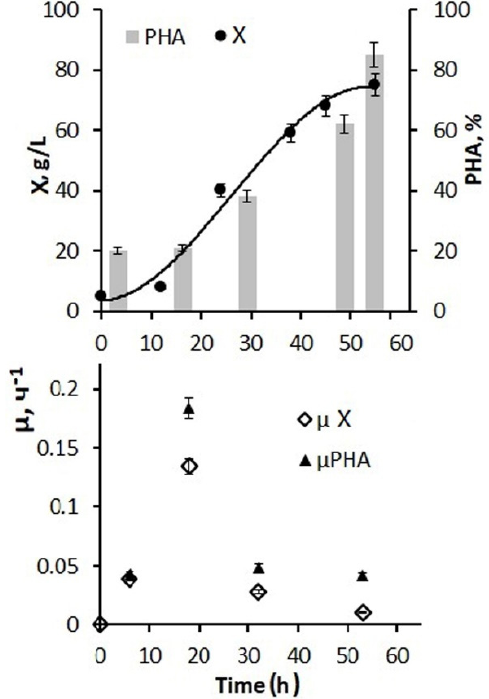
Figure 4. Production parameters of Cupriavidus necator B-10646 culture when cultivated in the 8 L fermenter using 20-fold dilution of molasses hydrolysate, concentrated inoculum (5 g/L), and a larger amount of glucose and phosphorus supplementation as a source of carbon, nitrogen, and mineral elements at the first stage with feeding with phosphorus and glucose; at the second stage—in a nitrogen-free medium with culture fed with glucose and phosphorus (feeds are shown by arrows): the concentration of the total cell biomass in the culture (X, g/L) and the polymer in the cells (PHA% of CDW); specific cell growth rate (µX h − 1 ) and specific polymer synthesis rate (µPHA, h − 1 ).